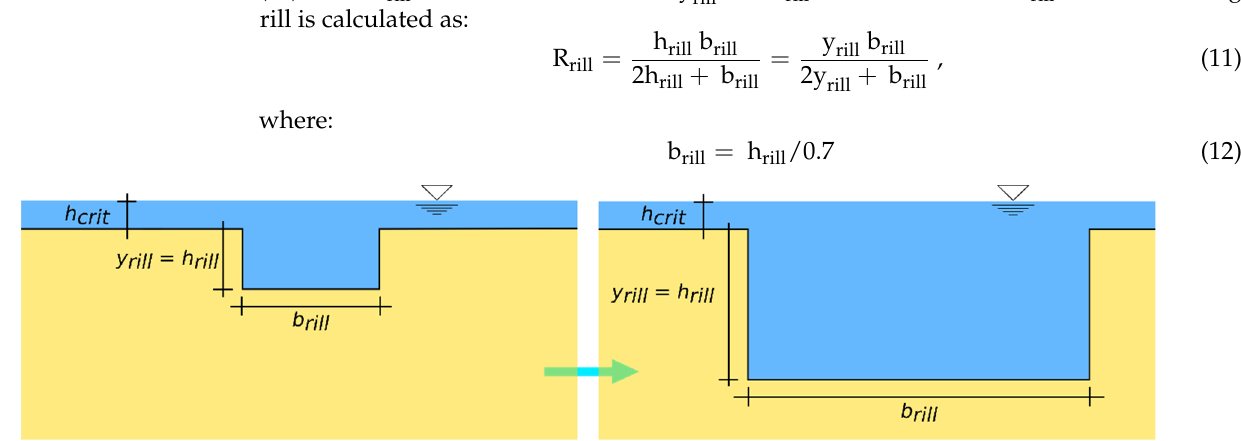
Figure 1. Scheme of the rill size during increasing surface runoff.